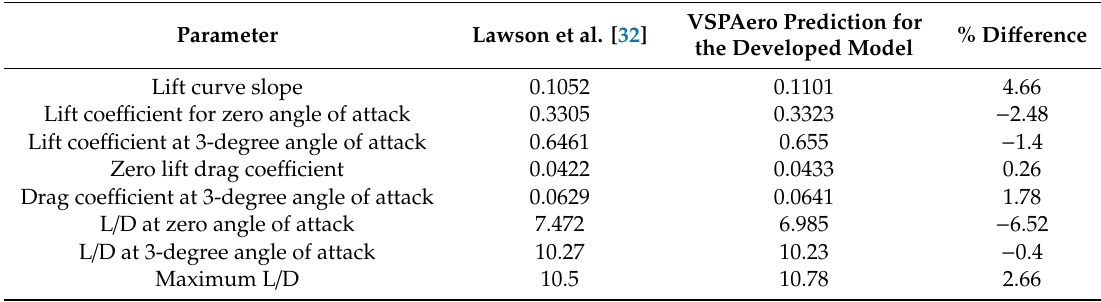
Table 8. Comparison with the flight test data [33]. L / D: lift-to-drag